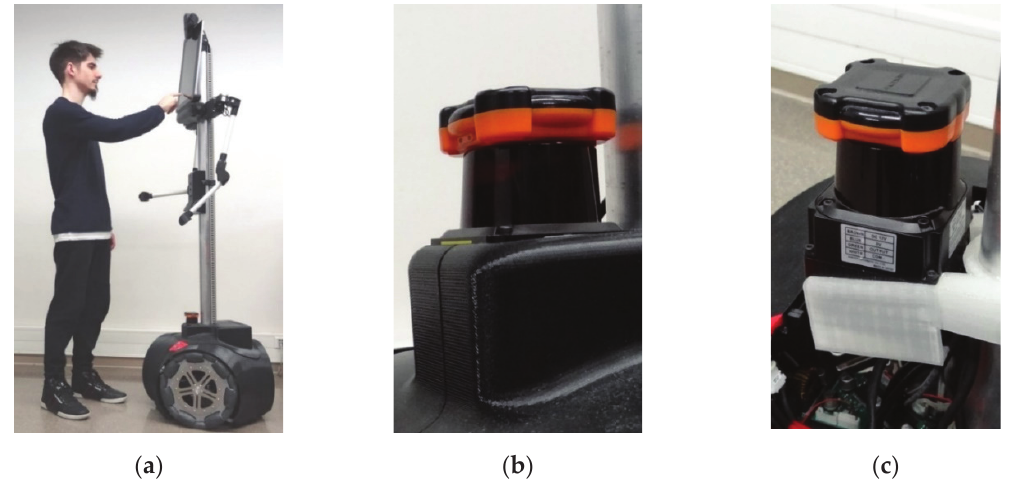
Figure 1. ( a ) APR-03 mobile robot operated by an author of this paper. ( b ) Close-up image of the onboard LIDAR sensor. ( c ) Detail of the onboard LIDAR without the protective housing